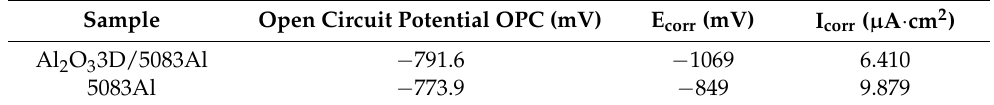
Figure 4. ( a ) Open circuit potential (OCP) curve; ( b ) potentio-dynamic polarization (PDP) curve. Table 2. Corrosion potential and corrosion current.